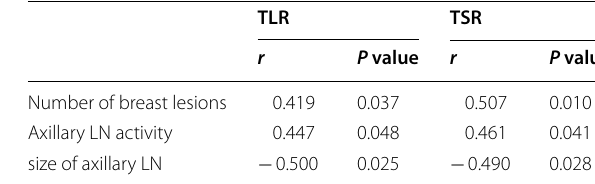
Table 5 Correlation between TLR and TSR and PET/CT findings